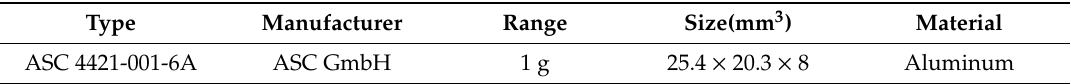
Table 3. Parameters of capacitive accelerometer.